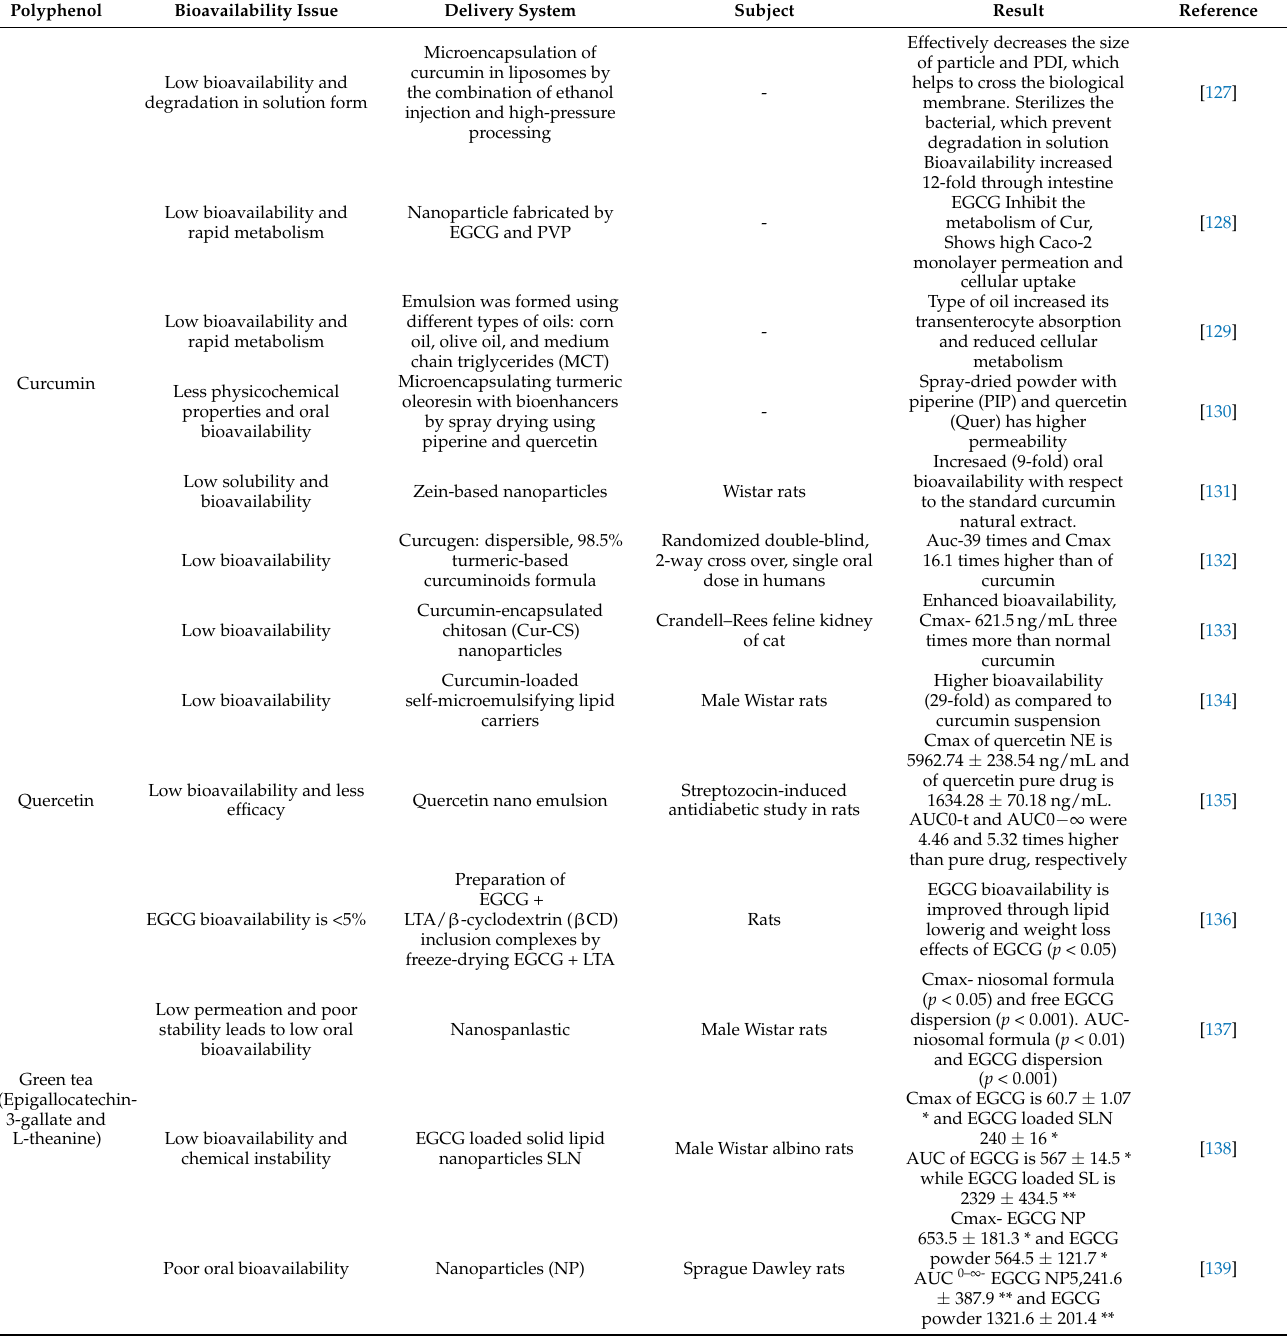
Table 2. Bioavailability issues of polyphenols and various pharmaceutical formulations/delivery systems to overcome